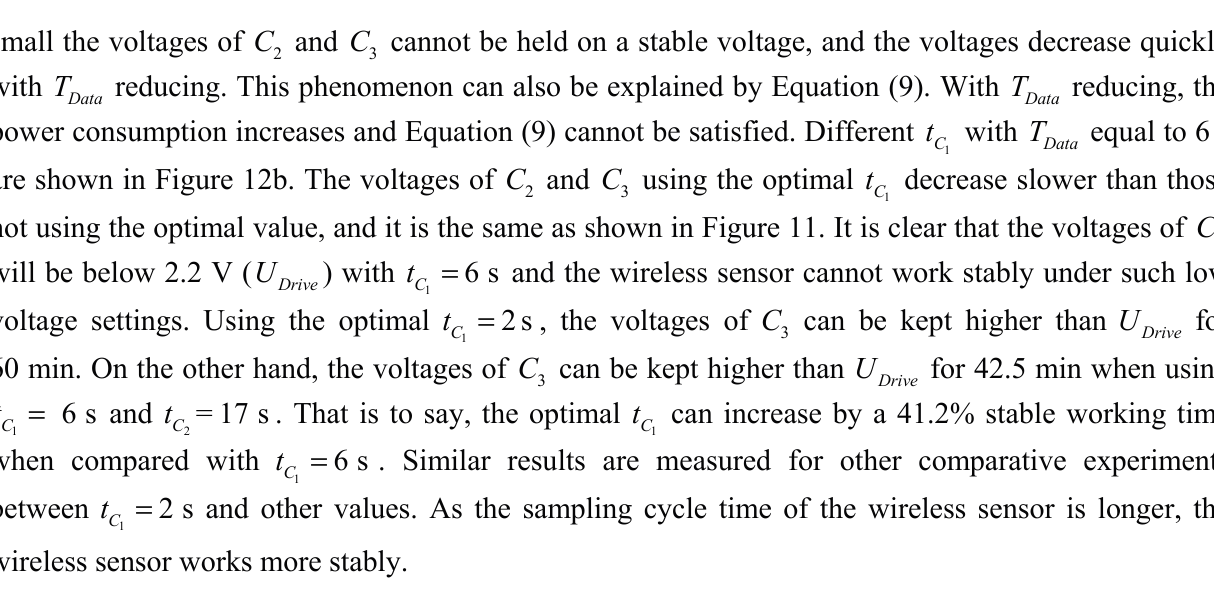
C and C . ( a ) Different time cycles; ( b ) Different 2 3